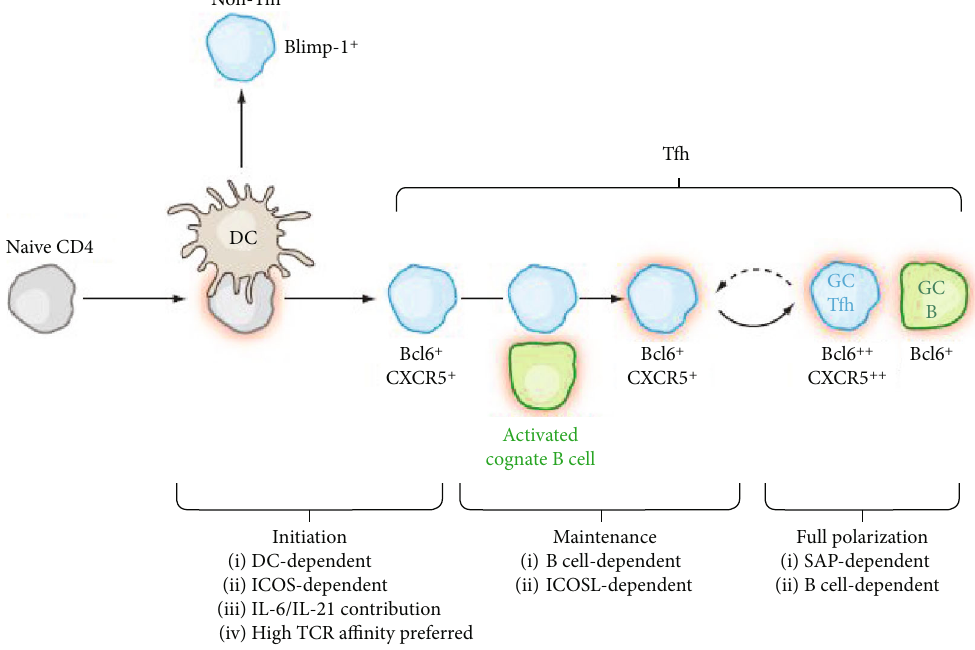
Figure 1: The di ff erentiation of Tfh cells: multiple stages of Tfh cell di ff erentiation, including initiation, maintenance, and full polarization stages (Annual Review of Immunology, 2011,29(1):621-663).